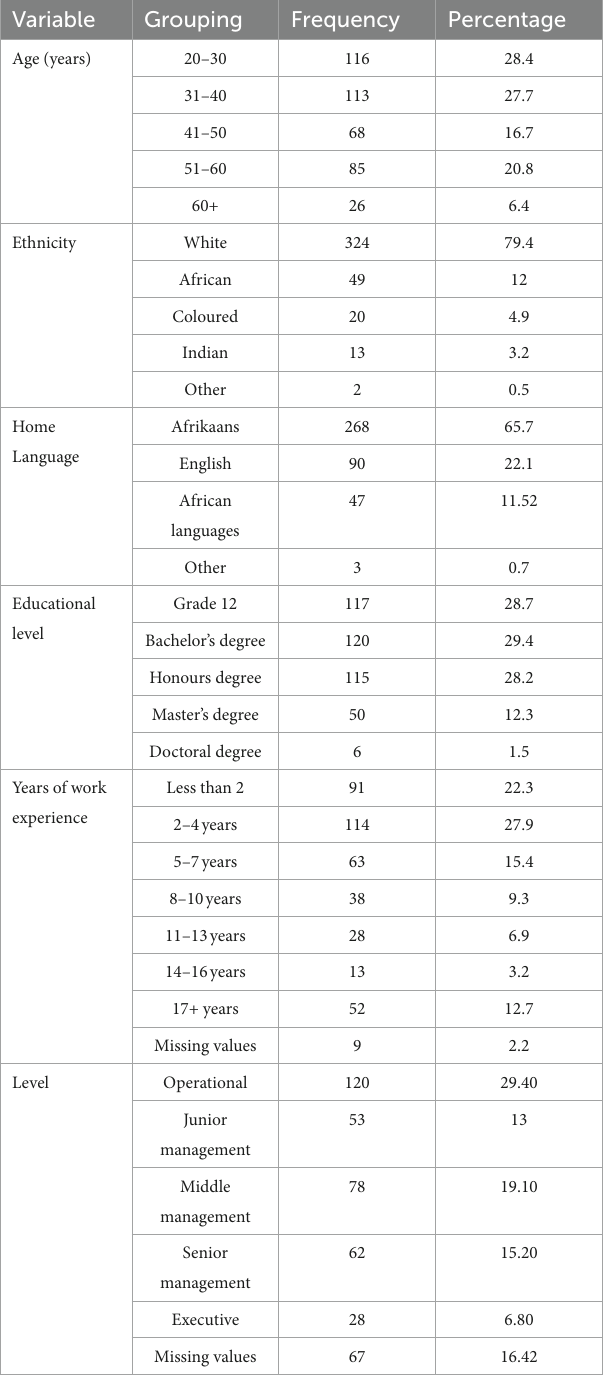
TABLE 1 Demographic profile of the sample ( N =